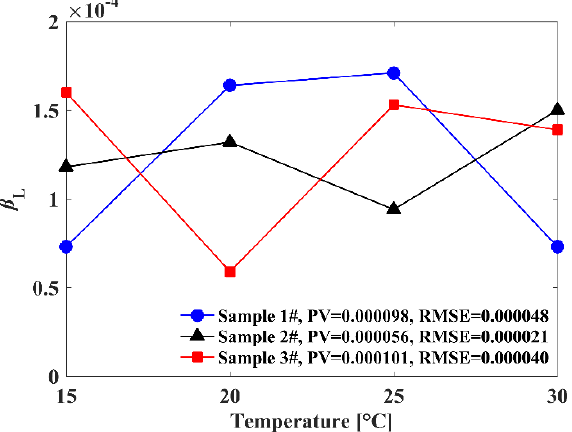
Figure 9. The relationship between 𝛽 (cid:2896) and temperature for ULE samples with different CTEs.